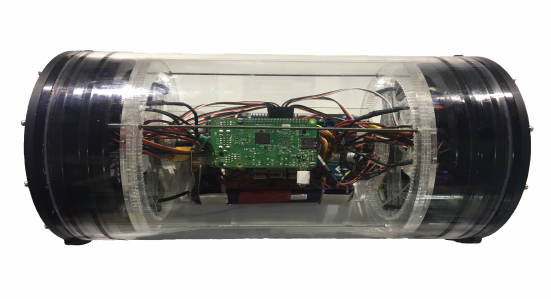
Figure 2. Watertight Enclosure used for electronic devices in the prototype